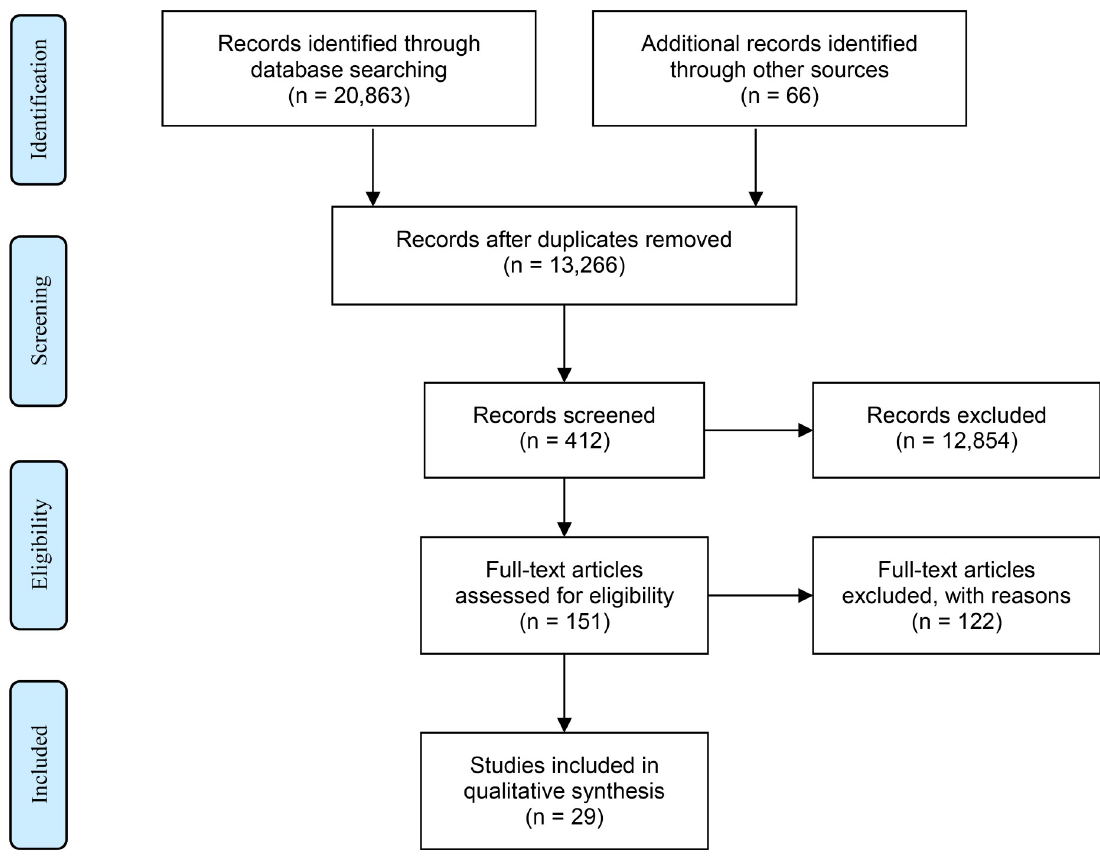
Fig 2. Prisma flowchart.